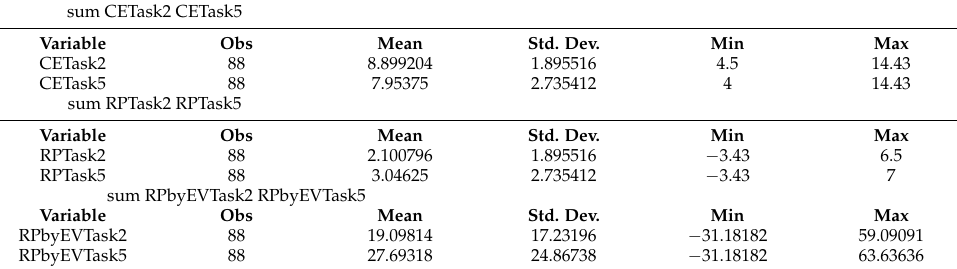
Table A7. Descriptive statistics of CE, RP, and